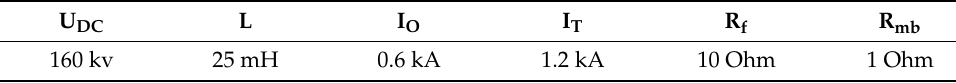
Table 3. Parameters used in